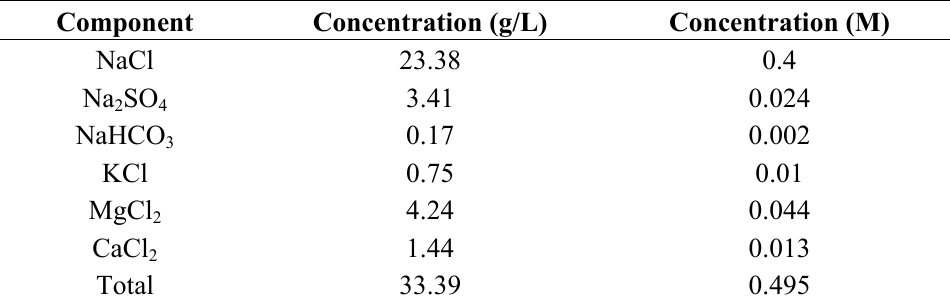
Table 1. Composition of synthetic sea water